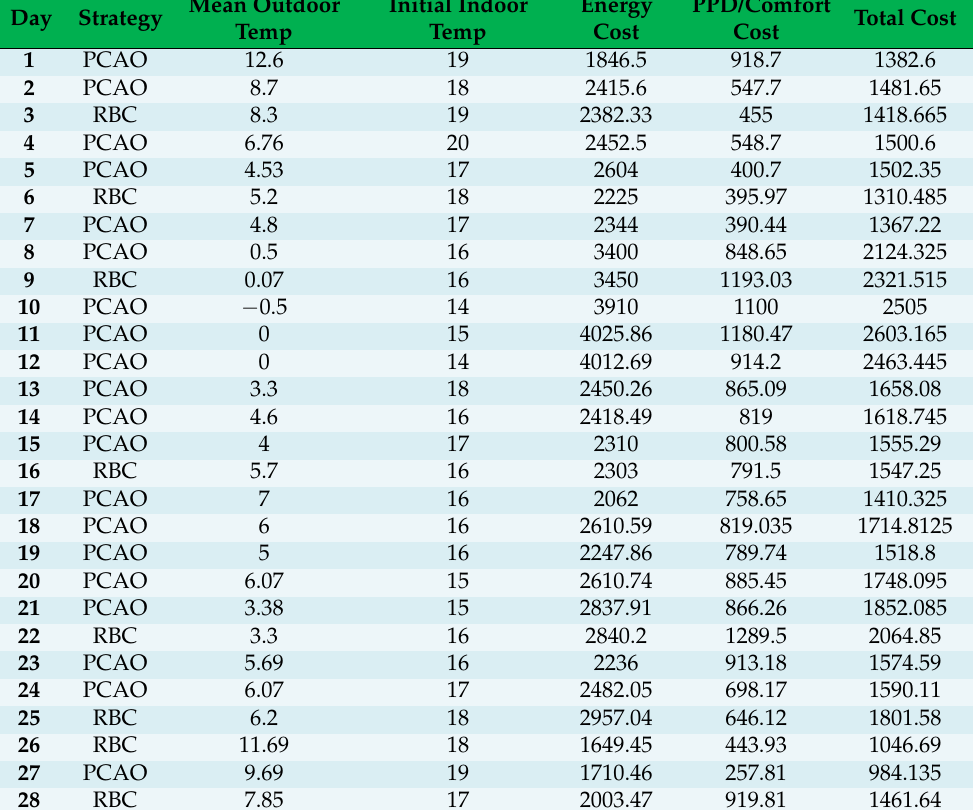
Table 4. Experiment results